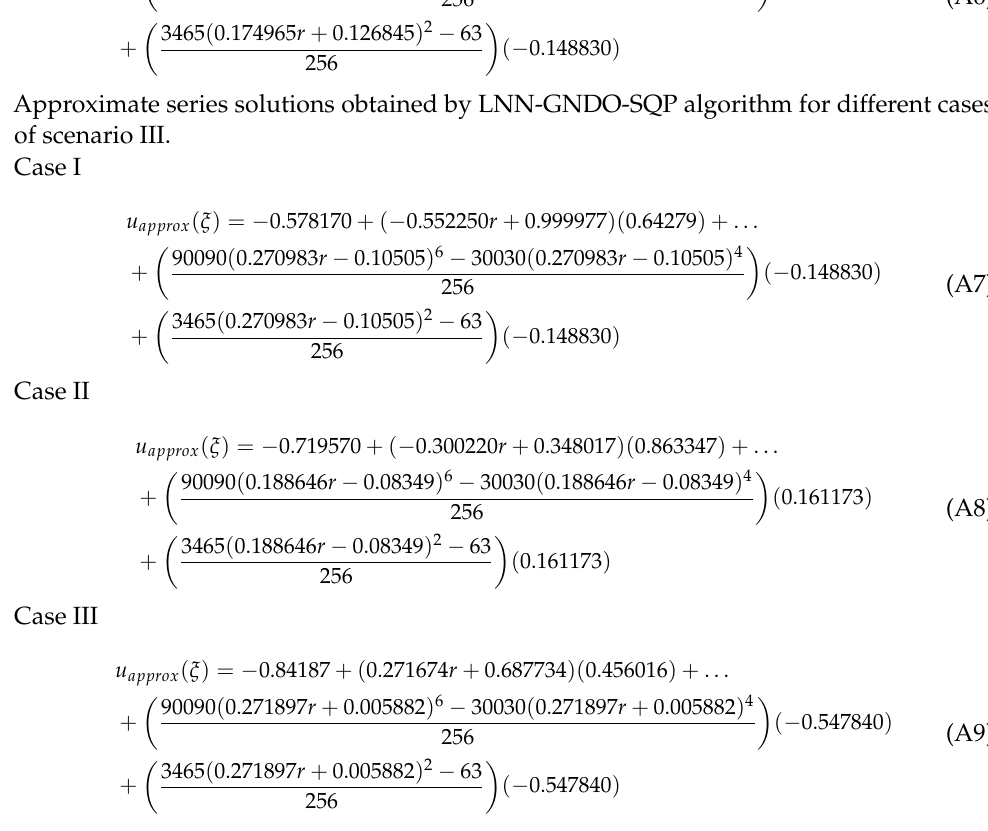
Approximate series solutions obtained by LNN-GNDO-SQP algorithm for different